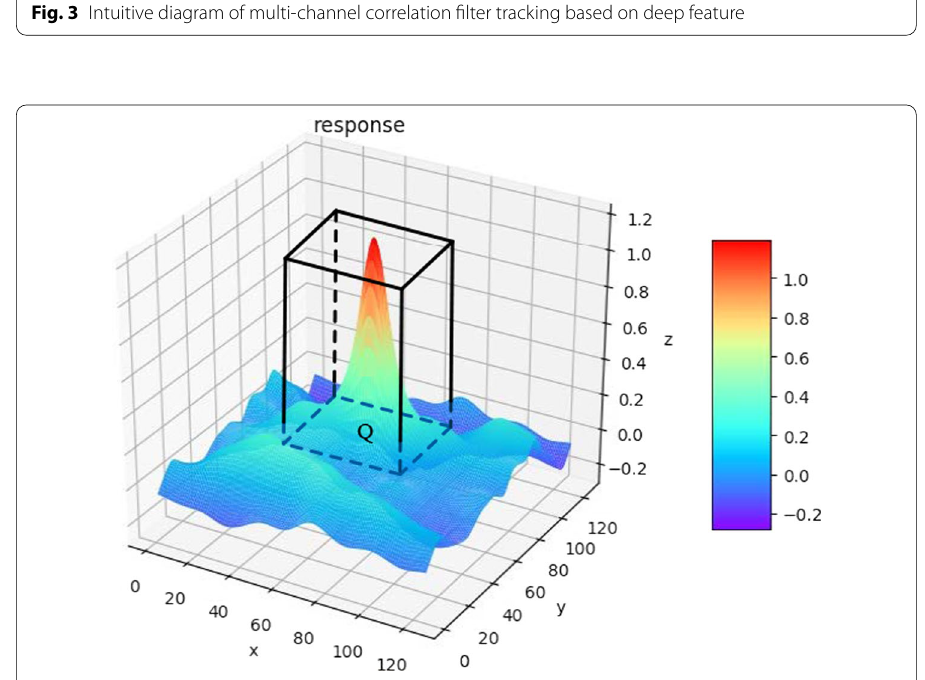
Fig. 4 Intuitive diagram of tracking target total